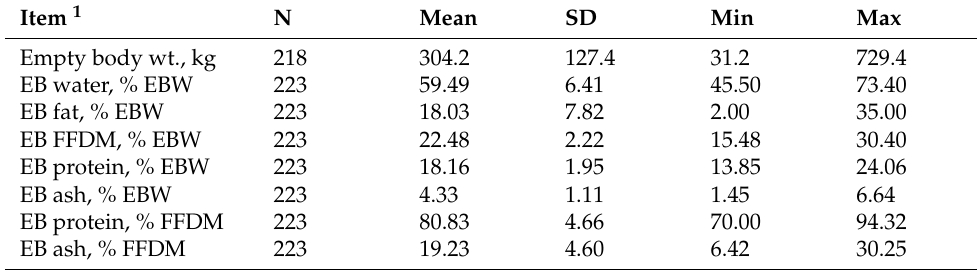
Table 4. Summary statistics of empty body chemical composition of cattle in the Empty Body dataset.